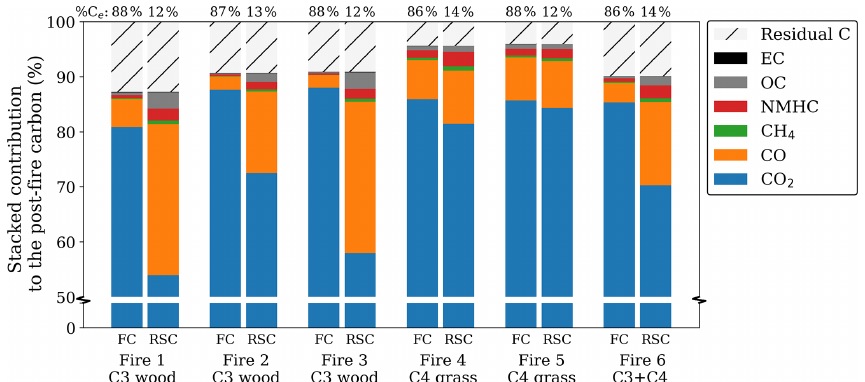
Figure 1. Post-fire partitioning of carbon for the flaming (left) and smouldering (right) phase for oak wood chips (C 3 ) and prairie grass (C 4 ). Note that the bottom 50%, containing only CO 2 , was cut from the graph to emphasize the smaller fractions. The numbers over the bars represent the percentage of carbon emitted in each phase. As the residue was only measured at the end of the fire, the residual carbon, calculated as the post-fire carbon in the residue over the pre-fire carbon in the fuel, was equally allocated to both phases. Carbon in NMHC was estimated to be 3.5 times the carbon in CH 4 based on Andrea (2019).